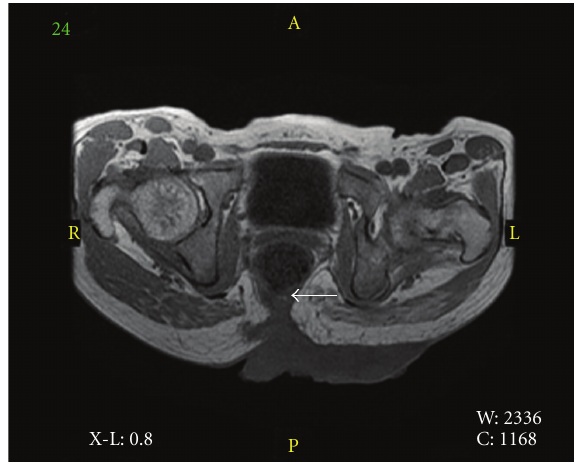
Figure 2: The mass invaded into coccygeal bone and the rear side of rectum (arrow).